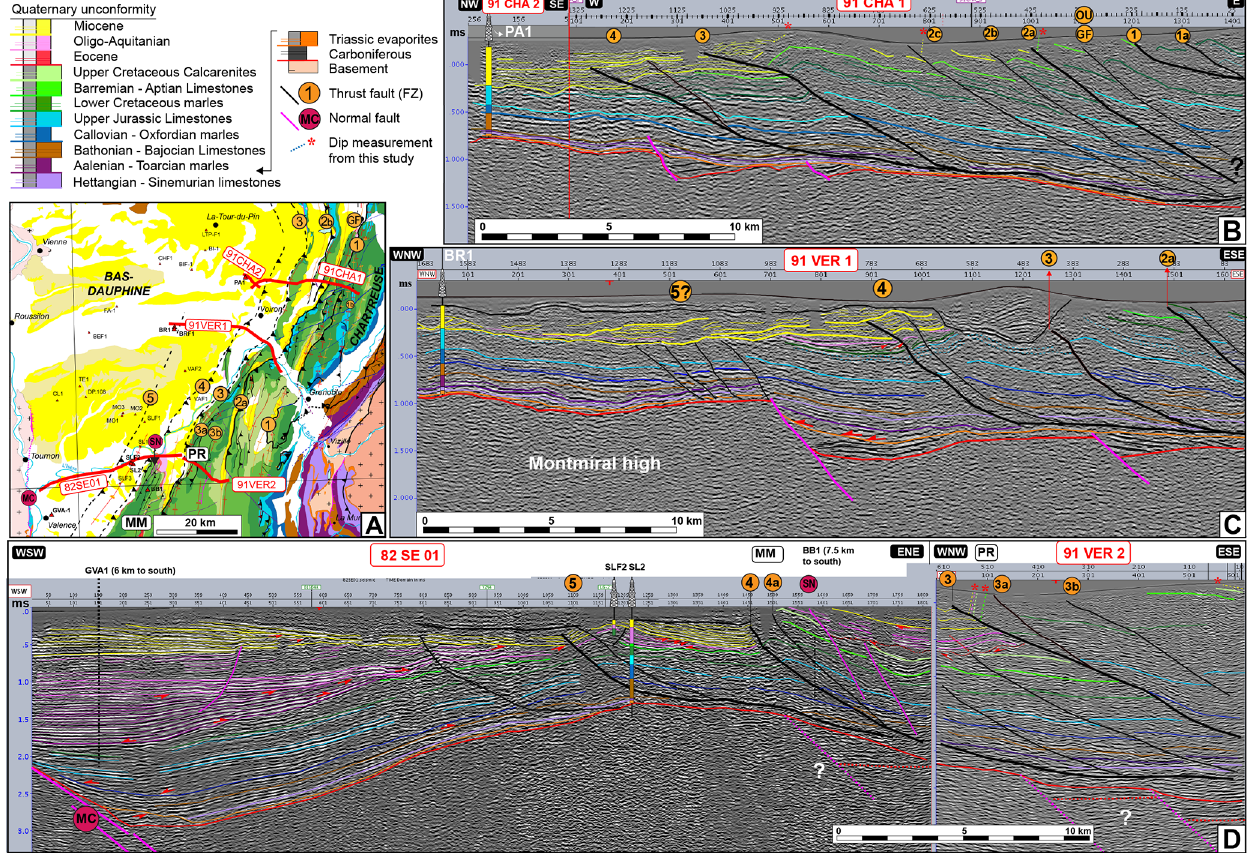
Figure 9. Seismic profiles along the Vercors and Chartreuse massifs (seismic lines published by Deville, 2021, and reinterpreted). (A) Ge- ographical and geological locations of the interpreted seismic lines. (B) Seismic profiles 91CHA1 and 91CHA2. Interpretation is proposed using PA-1 well data and fieldwork data. Note that the Outherans blind thrust (OU) corresponds further north to the GF thrust. (C) Seismic profile 91VER1. Interpretation is proposed using BR-1 well data and fieldwork data. (D) Seismic profiles 82SE01–91VER2. Interpretation is proposed using SLF-2, SL-2, and extrapolated BB1 and GVA-1 well data and fieldwork